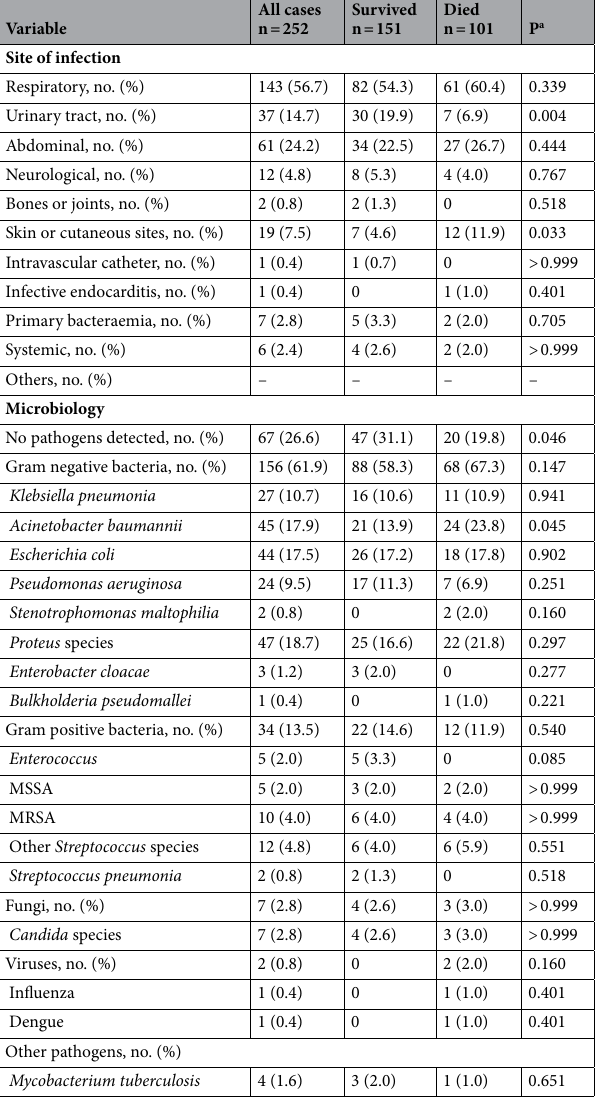
Table 4. Sites of infection and microbiology according to hospital survivability of patients with sepsis. MRSA methicillin-resistant Staphylococcus aureus , MSSA methicillin-susceptible Staphylococcus aureus , no. number. a Comparison between survived and died patients with sepsis.